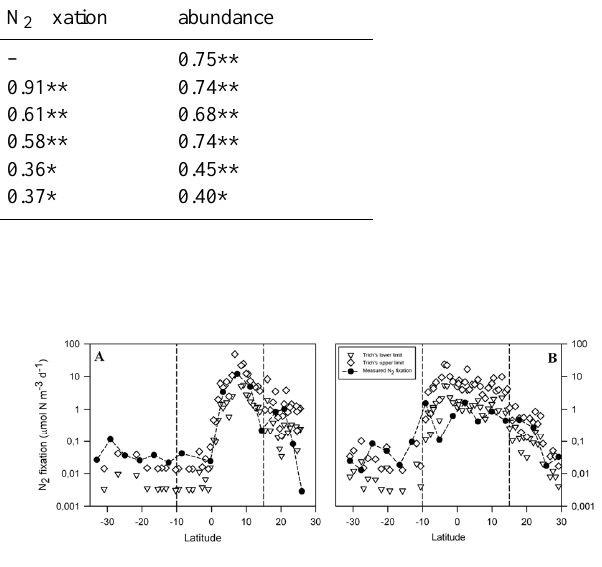
Fig. 10. Comparison of the latitudinal distribution of measured sur- face N 2 fixation (black circles) with the estimated lower (open tri- angles) and upper (open diamonds) limit for N 2 fixation due to Tri- chodesmium spp. during the 2007 (a) and 2008 (b)